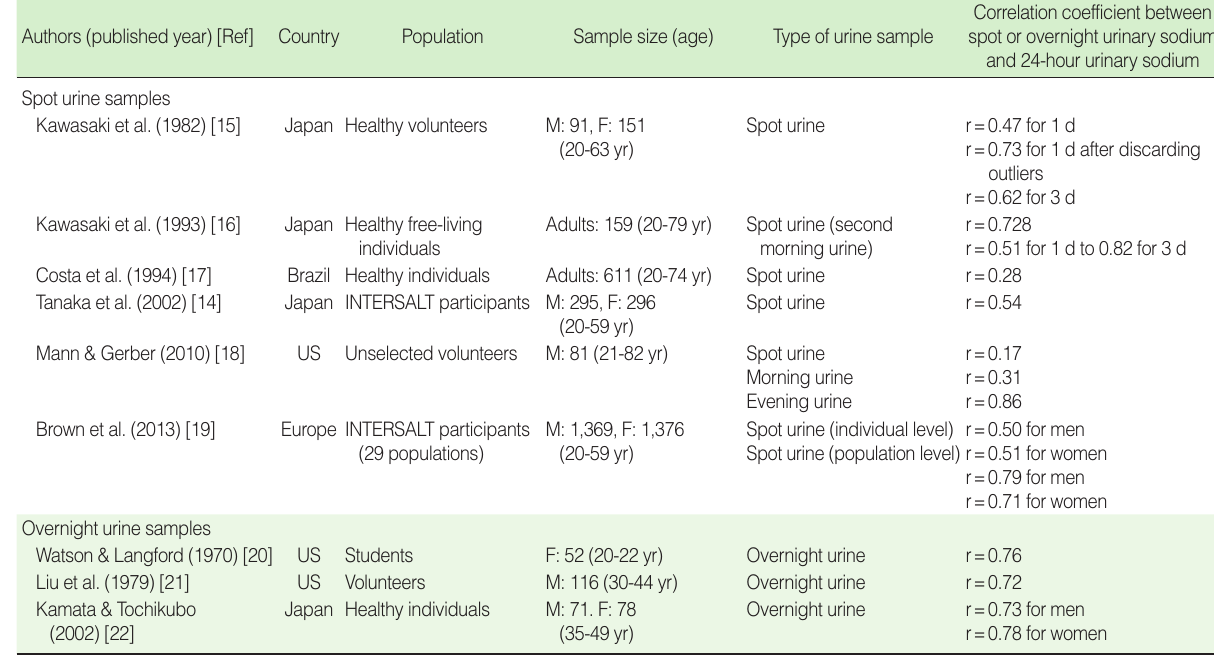
Table 2. Studies that compared spot or overnight urine samples with the 24-hour urine samples for the estimation of sodium intake in a healthy